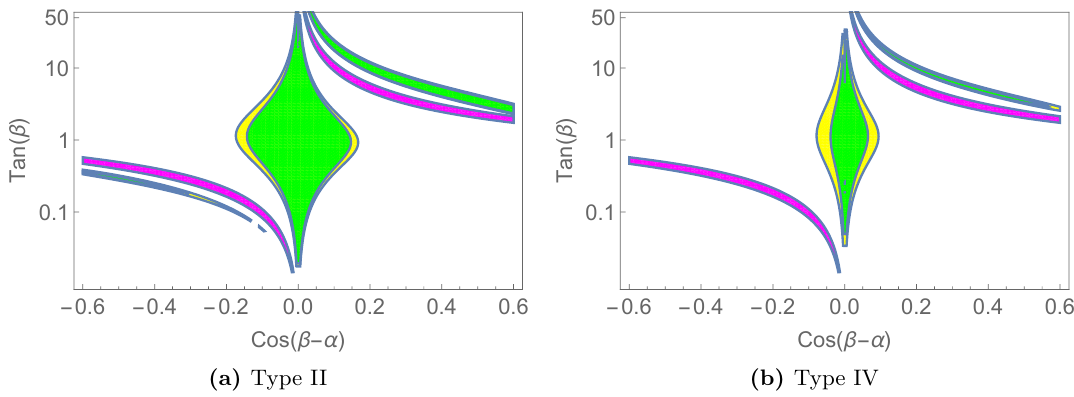
Figure 2. Viable regions in the t (cid:12) (cid:0) c (cid:12) (cid:0) (cid:11) plane for (a) Type II and (b) Type IV models, at one (green) and two (yellow) sigma. The region satisfying the upper bound on BR( h ! AA ) for m A = 30 GeV is given in